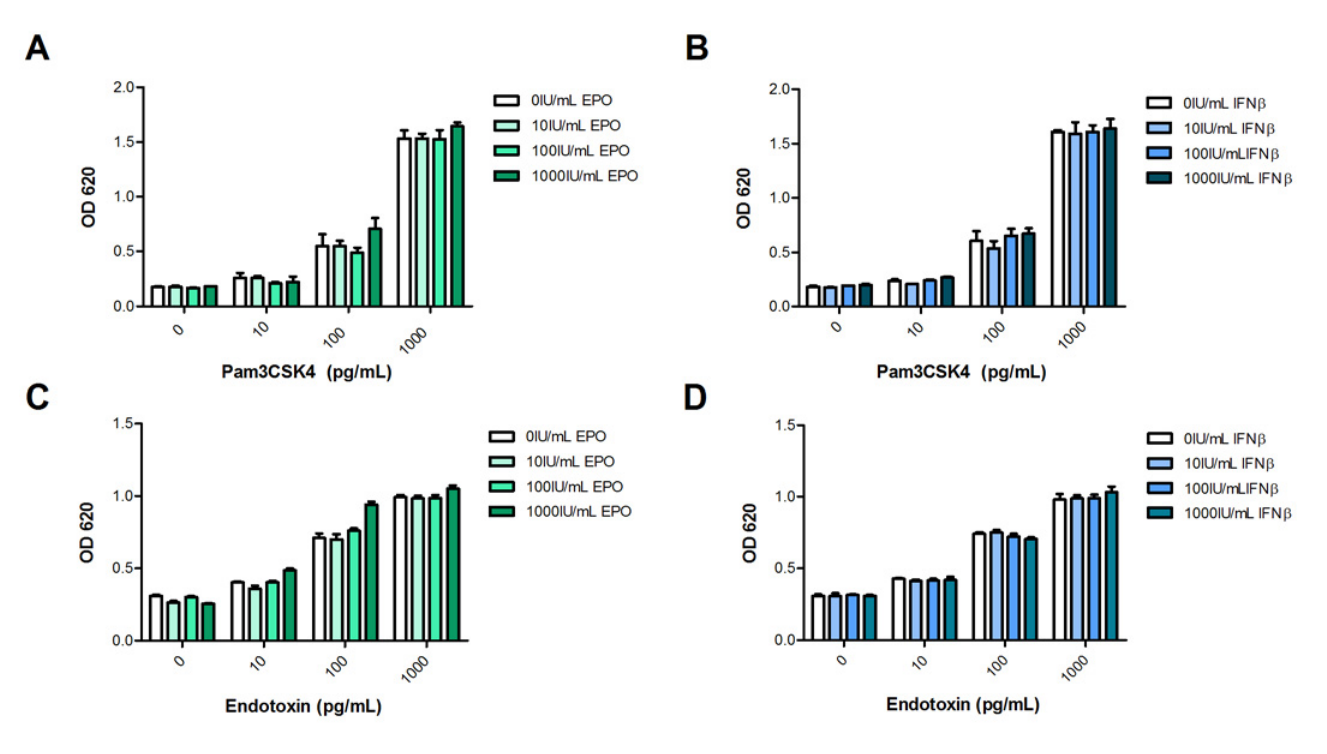
Fig 2. HEK-BLUE-hTLR transfectants detect trace levels of impurities in therapeutic products. ( A-B ) A total of 5x10 4 HEK-BLUE-hTLR2 ( C-D) 2.5x10 4 HEK-BLUE-hTLR4 were cultured for 24h with increasing concentrations of Pam3CSK4 and Endotoxin in the presence of 0-1000IU/mL of EPO and IFN β to assess the sensitivity of the cell lines and the product interference. NF- κ B activation was measured from the supernatant after the addition of QUANTI-Blue. Each point represents mean ± SD of triplicate cell culture.